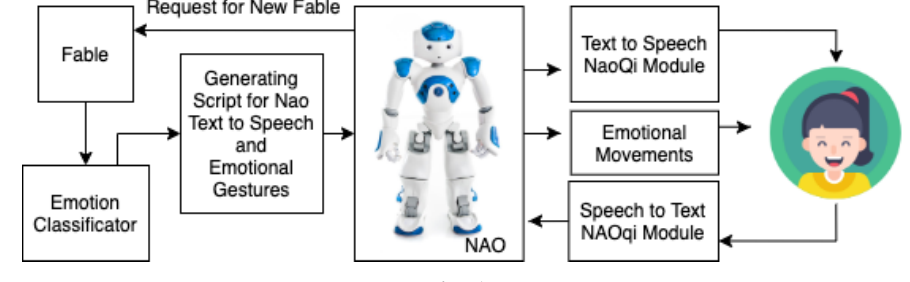
Figure 10. Setup for the experiment